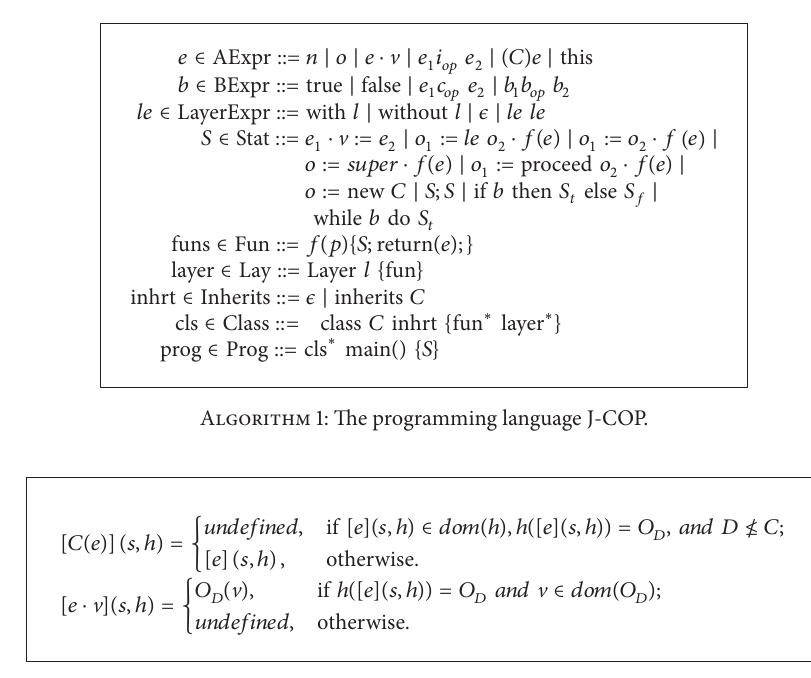
Algorithm 2: Semantics of J-COP